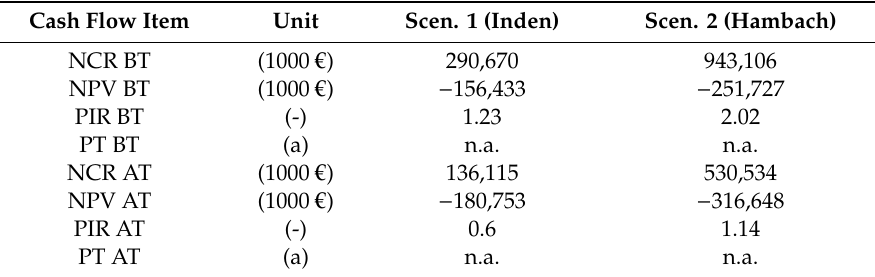
Table 12. Economic evaluation for both scenarios, flooding time included.